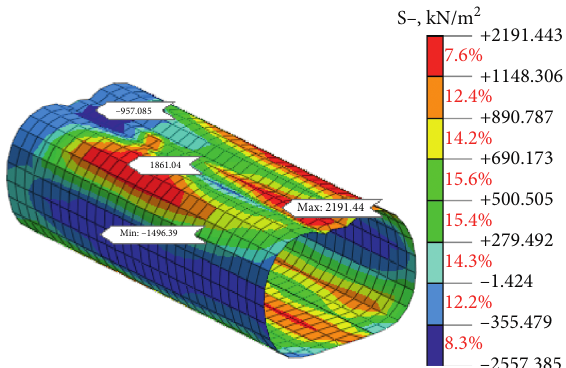
Figure 15: Principal stress of initial support in the optimization scheme (unit: kN/m 2 ).